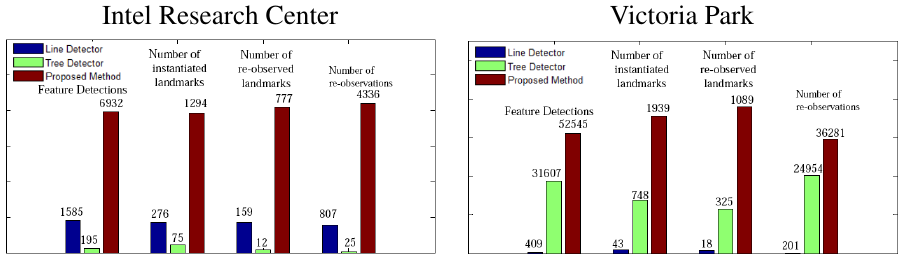
Figure 10. Feature detection performance. Three detectors ran on two different datasets: Intel Research Center (indoor) and Victoria Park (outdoor). New features were instantiated when a new detection was far away from any previous landmarks. A larger number of loop closures (re-observations) generally leads to better maps. Four important indicators for feature detectors were compared, which are feature detection amount, instantiated landmark amount, re-observed landmark amount and the re-observation amount. The two histograms show that our method outperforms the other two methods even in the environments for which the specialized methods were designed.